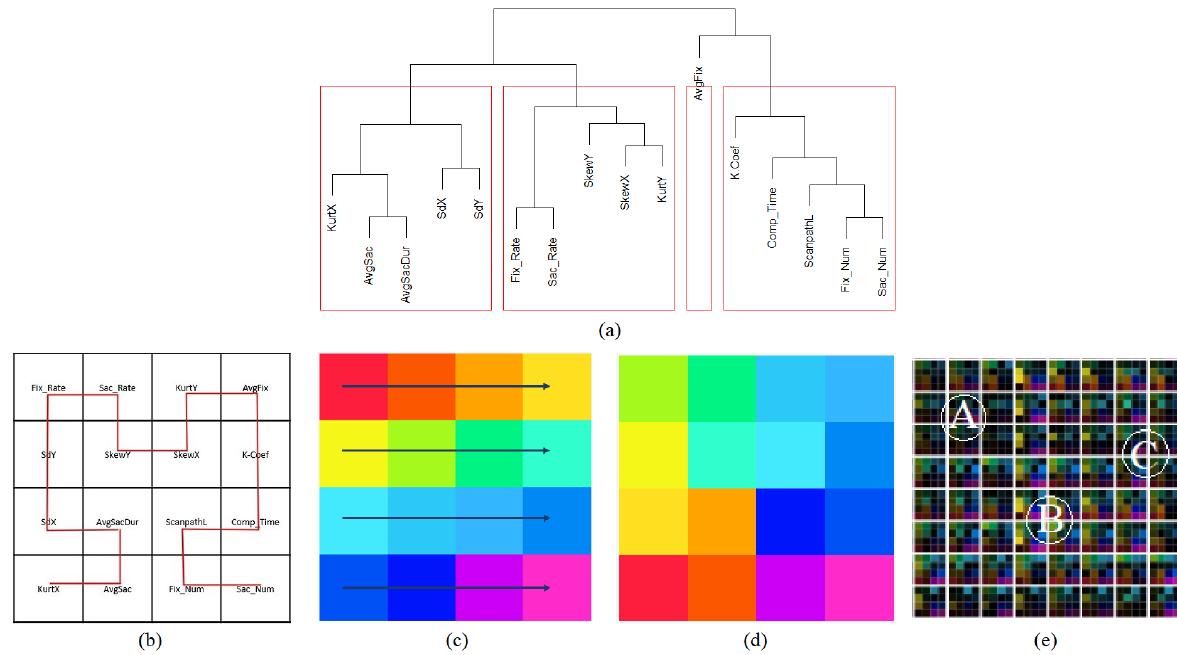
Figure 6. Overview of the procedure followed in the generation of Dimensionally Stacked Similarity Matrix (DSSM). The dendro- gram shown in Figure (a) reveals the proximity between metrics from eye-tracking data. Figure (b) shows the order in which metrics are stacked in the similarity matrix following a second-order Hilbert curve. Figure (c) shows the 16 colors with varying hue to repre- sent each similarity value in the sub-grid. Figure (d) shows that choosing the Hilbert curve preserves locality in colors. Figure (e) displays an example of multi-dimensional stacked metrics with dimension 8 𝑥 8 for 8 participants.